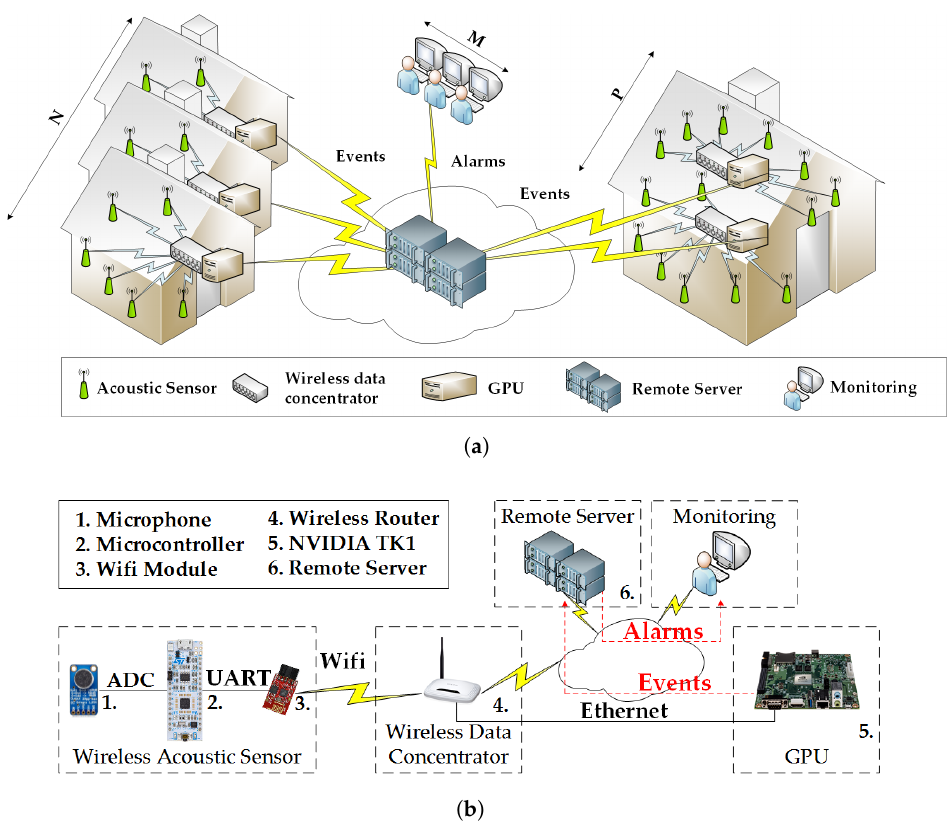
Figure 4. Network topology description of the proposed AAL system proposed and the technological proposal of the devices which integrate that system. ( a ) Network topology of the system and ( b ) subsystems that integrate that full system and the elements used in each